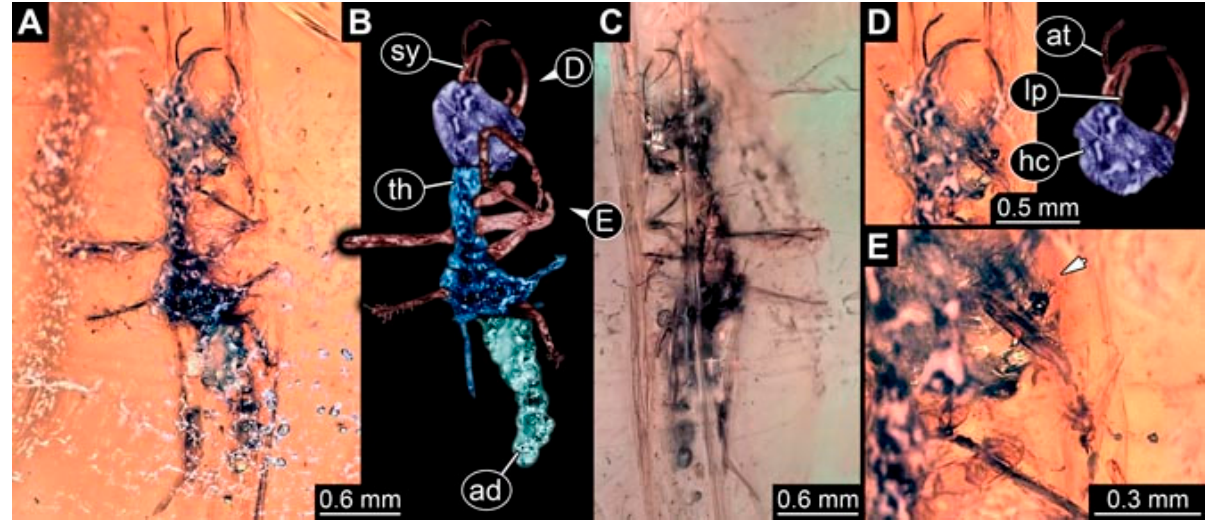
Figure 10. Specimen 4828 (PED 0034); Myanmar amber. ( A ) Ventral view. ( B ) Ventral view, colour- marked. ( C ) Dorsal view. ( D ) Close-up of head capsule in ventral view in original ( left ) and colour- marked version ( right ). ( E ) Close-up of trunk appendage with empodium (arrow). Abbreviations: ad = abdomen; at = antenna; hc = head capsule; lp = labial palp; sy = stylet; th = thorax.